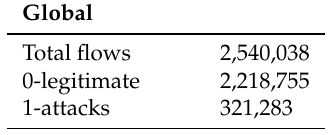
Table 2. The UNSW-NB15 dataset statistics.